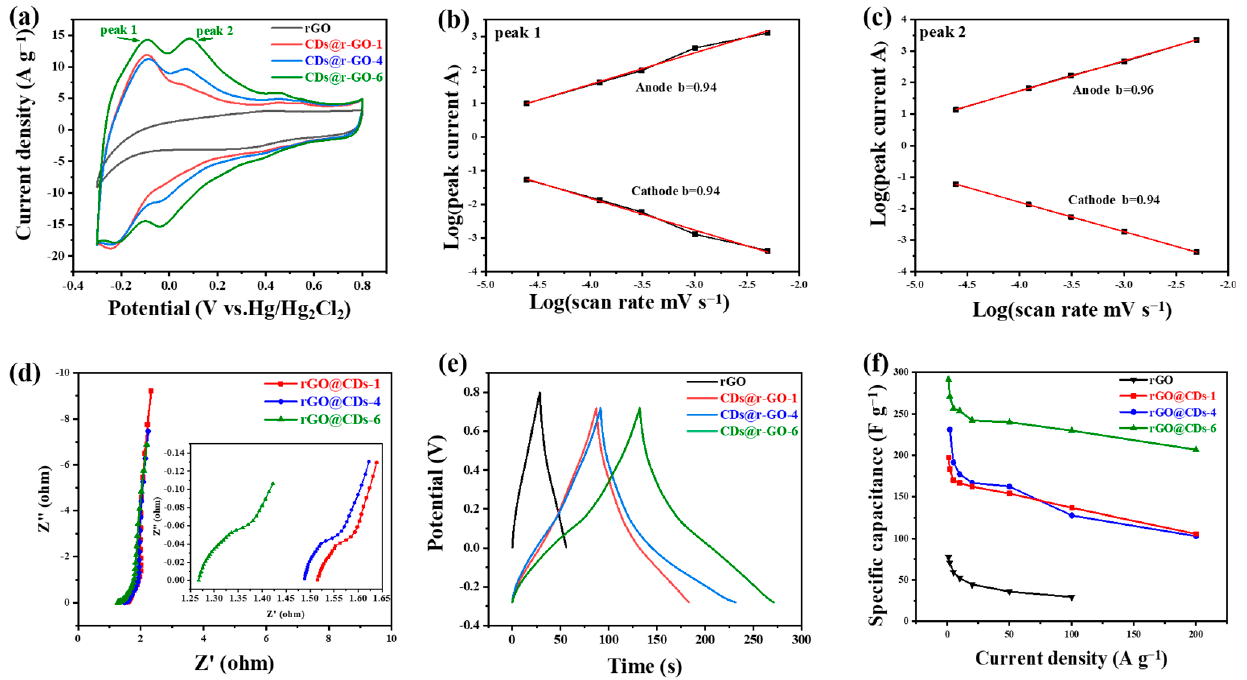
Figure 3. Electrochemical performance in 1 M H 2 SO 4 electrolyte and in a three-electrode configuration. ( a ) Cyclic voltammetry curves at a scan rate of 50 mV s − 1 ; ( b , c ) The plots of log (peak current) versus log (scan rate); ( d ) Nyquist plots; ( e ) Galvanostatic charge and discharge curves at a current density of 2 A g − 1 ; ( f ) Rate performance at different charge and discharge current densities of r-GO, CDs@r-GO-1, CDs@r-GO-4 and CDs@r-GO-6.